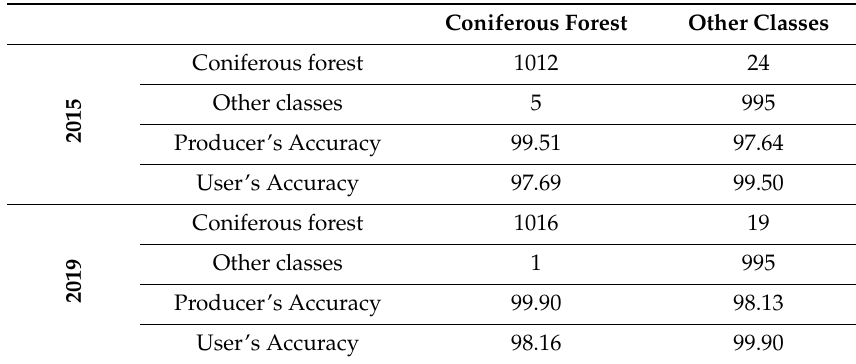
Table 2. Accuracy assessment of coniferous forest classification for 2015 and 2019. The number in the confusion matrix represents the number of pixels in the validation